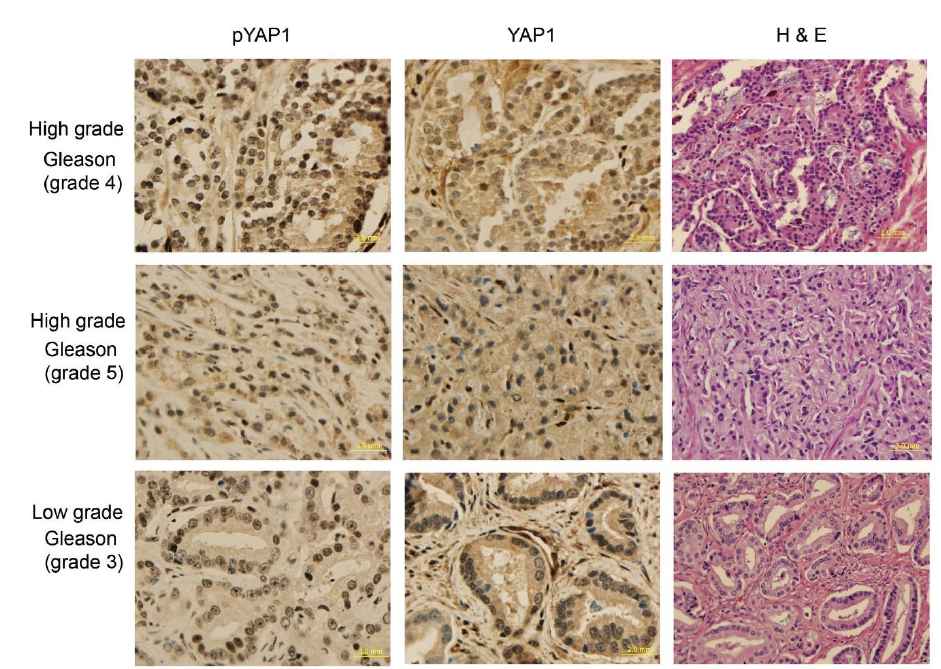
Figure 6. pYAP1(Y407) expression in nucleus of human PCa cells correlated strongly with gleason score increase. Human prostate tissues were stained for pYAP1(Y407) custom generated antibody and YAP1 (40×) and H&E (20×) as indicated. Different Gleason grades (high or low) shown. Scale bar 20 μ m.